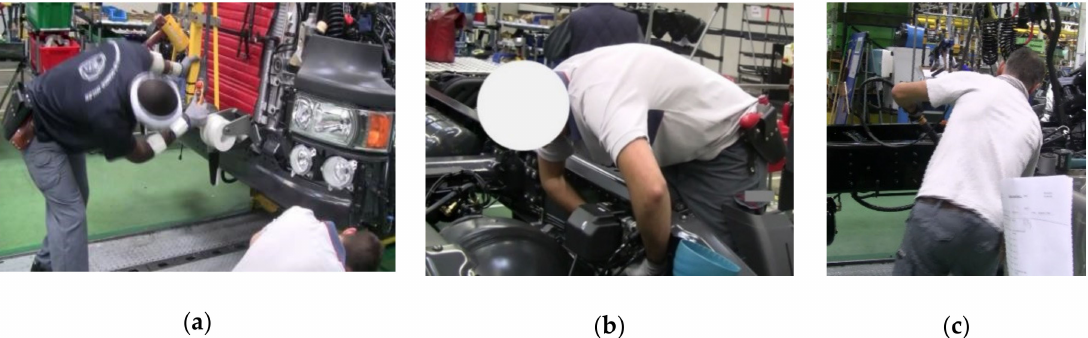
Figure 6. ( a ) Excessive awkward neck and back posture in the assembly bumper workstation due to positioning bumper on the truck’s chassis; ( b ) light cabling on the rear of the mudguard caused awkward back posture; ( c ) tightening with hydraulic screwdrivers required awkward postures and excessive